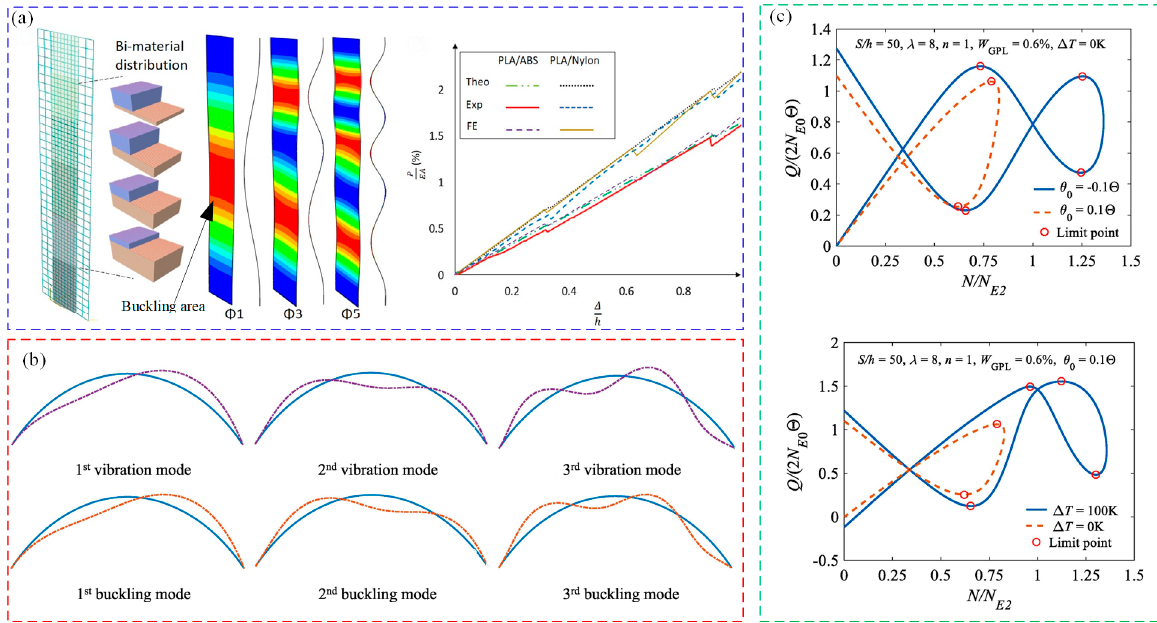
Figure 13. Buckling instability of functionally gradient beams: ( a ) numerical simulation, modal and experimental verification results of laminated functionally gradient materials (FGM) beams [160]; ( b ) relationship between free vibration and buckling modes of functionally gradient composite beams (FG-CB) [161]; ( c ) relationship of FG-CB load limit point number and loading position [162].